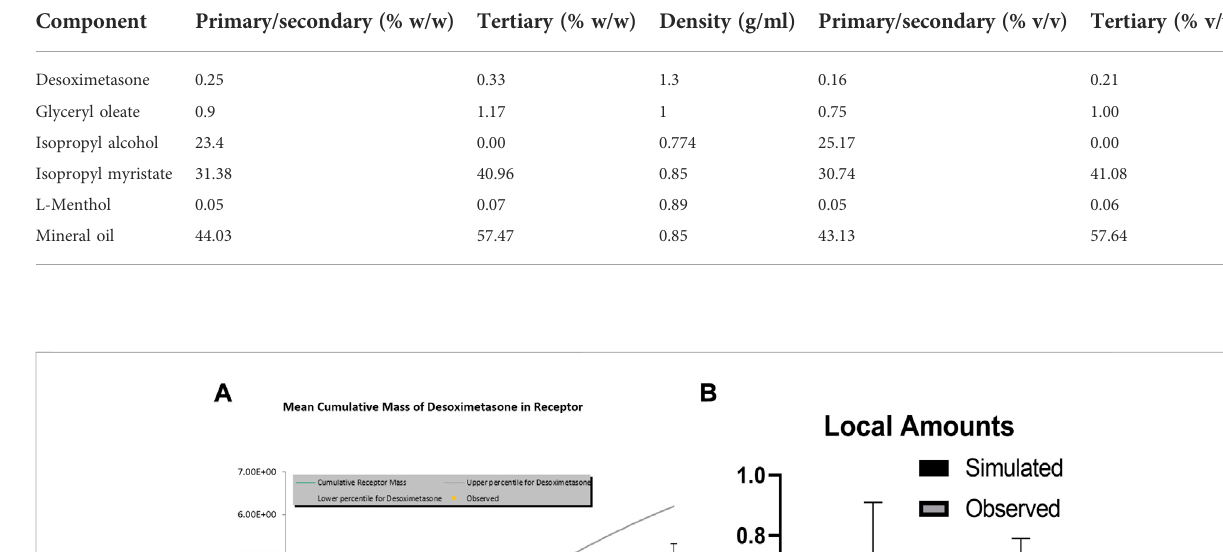
TABLE 2 Quantitative composition (Q2) of Topicort ® Spray.